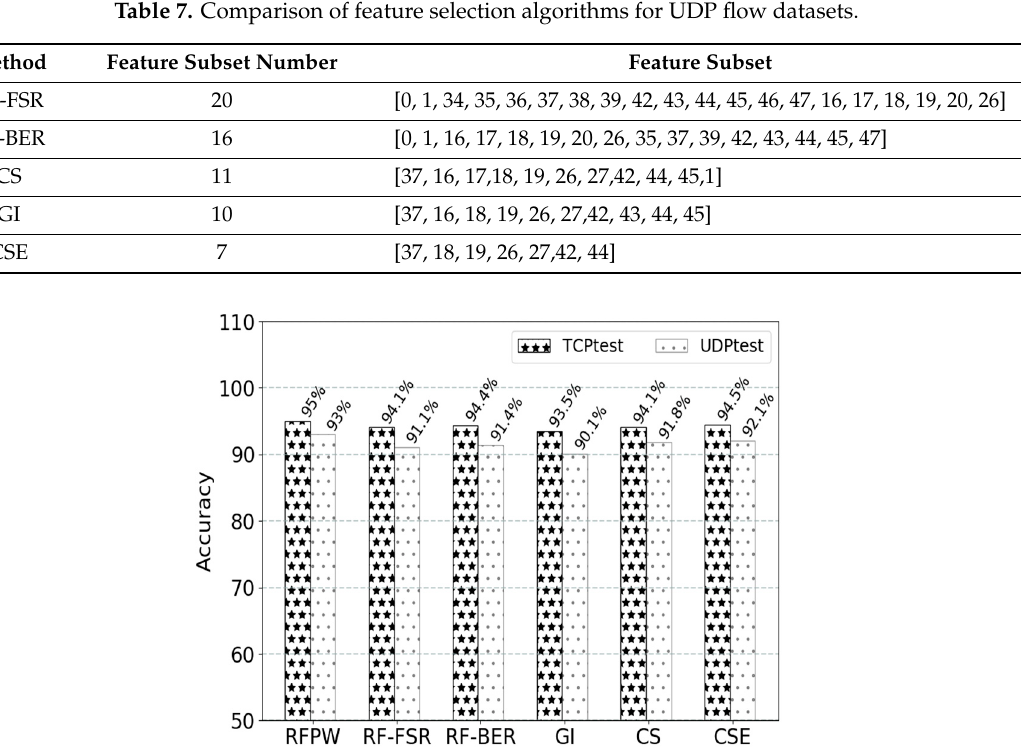
Table 7. Comparison of feature selection algorithms for UDP flow datasets.